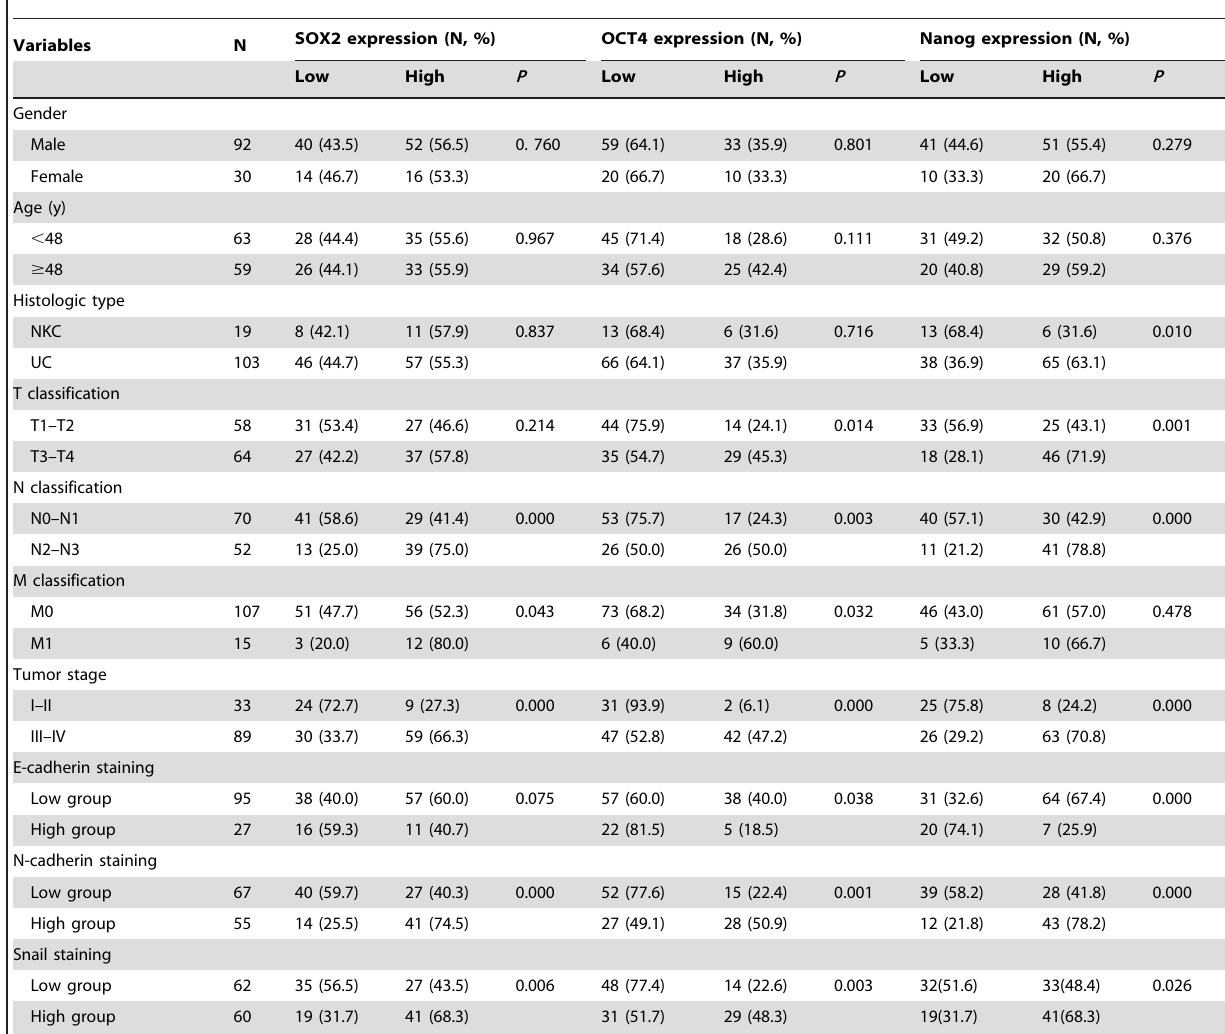
Table 1. Associations between the clinicopathologic factors and SOX2, OCT4 and Nanog expression in 122 NPC